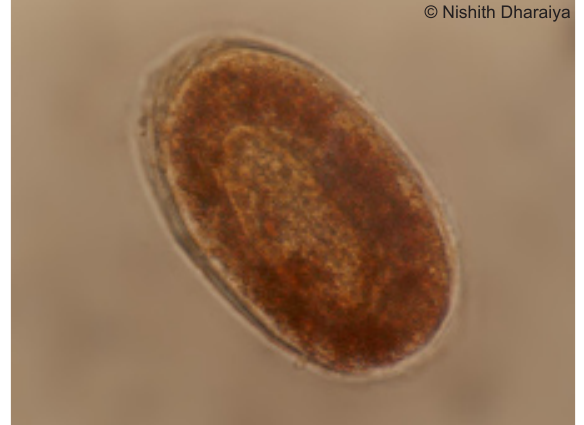
Image 5. Cross section of hair of Domestic Cow